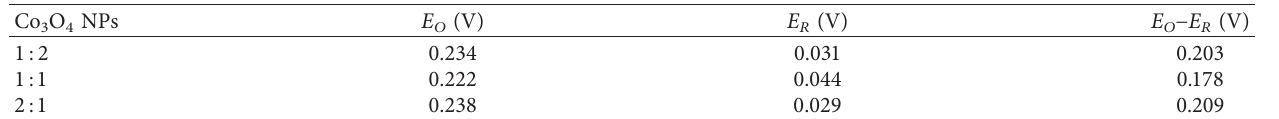
Figure 7: CV plots of Solanum tuberosum leaf extract templated synthesized Co 3 O 4 NPs electrode. (a) CV plots of Solanum tuberosum leaf extract templated synthesized Co 3 O 4 (1:2) NPs electrode. (b) CV plots of Solanum tuberosum leaf extract templated synthesized Co 3 O 4 (1:1) NPs electrode. (c) CV plots of Solanum tuberosum leaf extract templated synthesized Co 3 O 4 (2:1) NPs electrode. Table 1: The CV and EIS result for Co 3 O 4